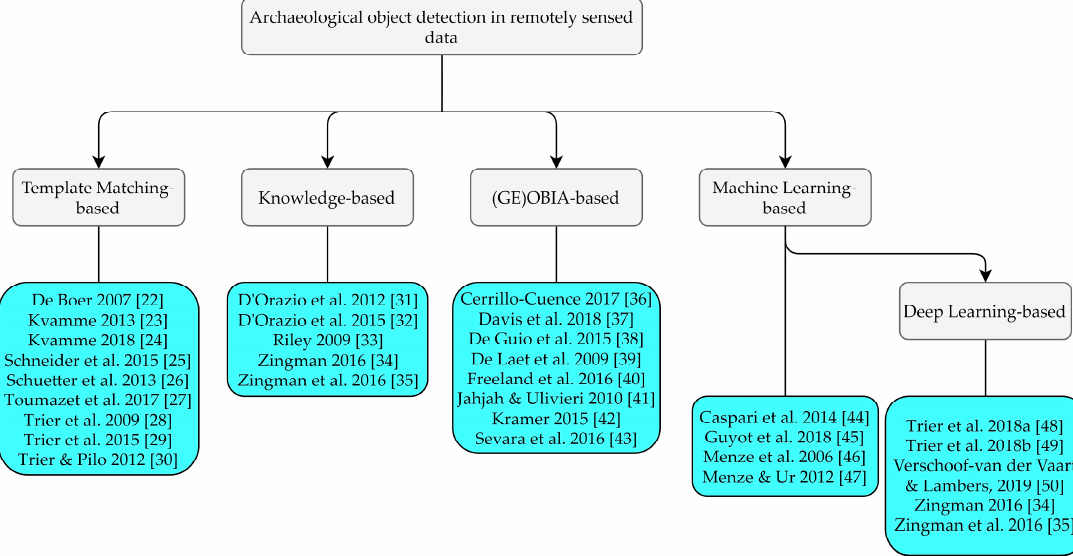
Figure 1. Classification of research on archaeological object detection in remotely sensed data, following Reference [14].